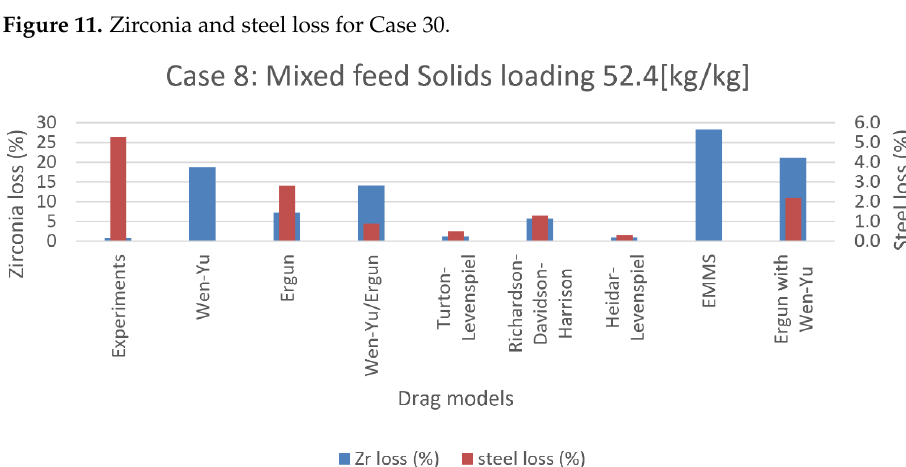
Figure 12. Zirconia and steel loss for Case 8.